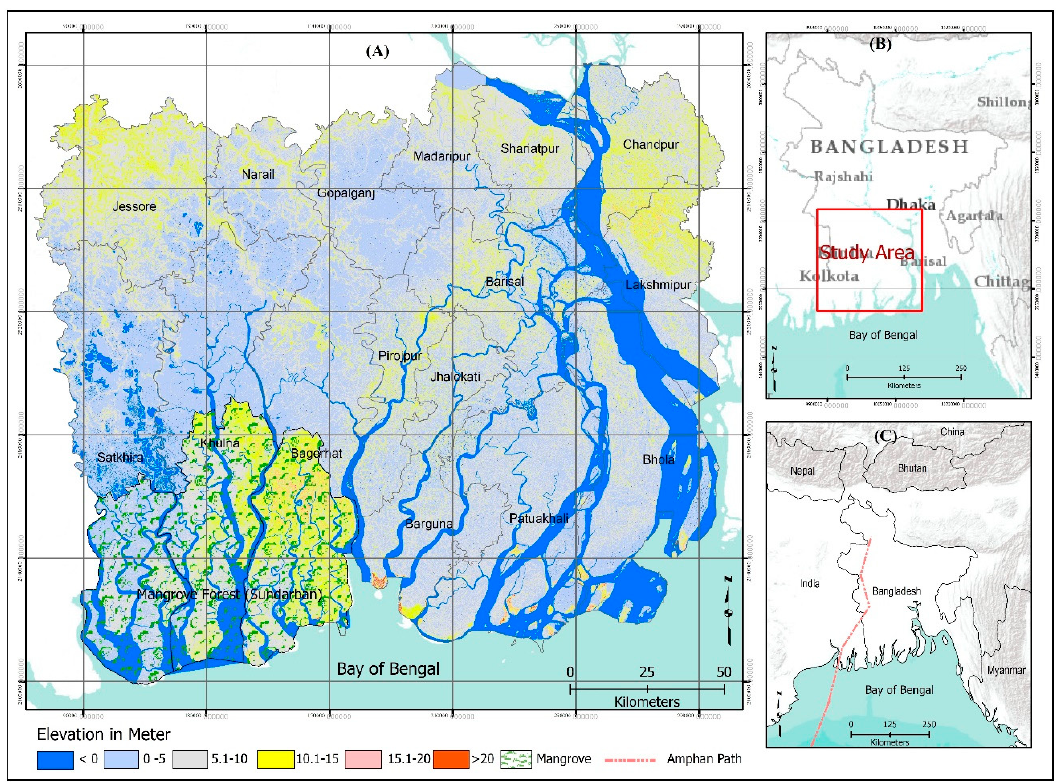
Figure 2. Map of the study area. ( A ) Elevation with administrative boundaries of 16 surveyed districts, ( B ) geographical position of the study area shown as a quadrilateral in the map of Bangladesh, and ( C ) path of cyclone Amphan crossing over India and Bangladesh between 16 May and 20 May.